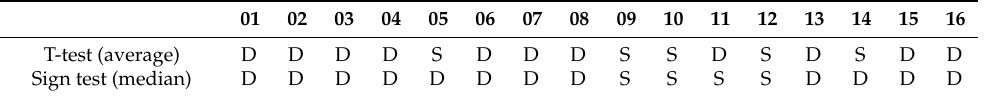
Table 7. Pair comparison of absolute results in both analysis variants.